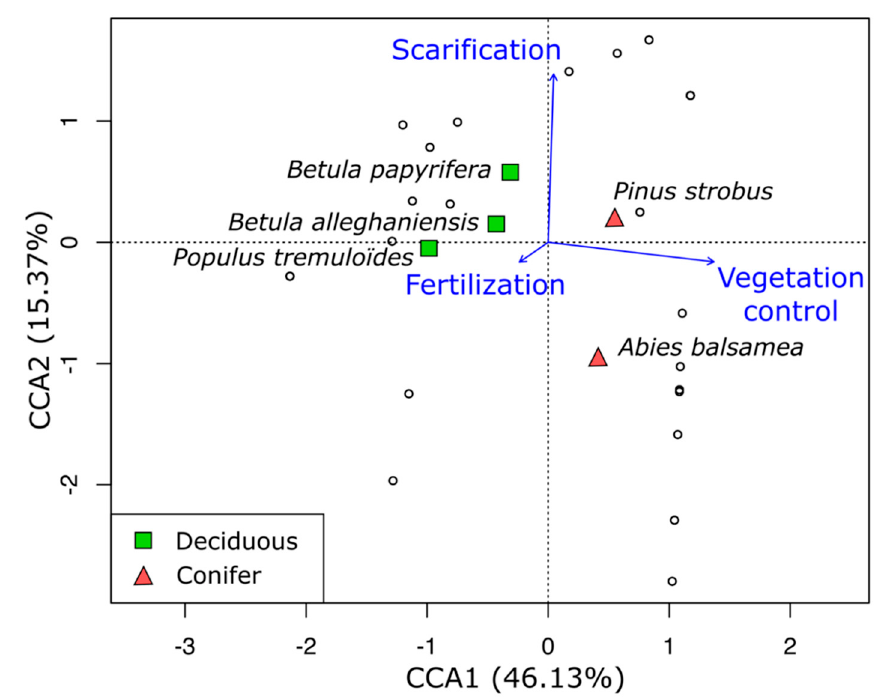
Figure 1. Canonical correspondence analysis of overstory vegetation composition using silvicultural treatments 27 years after establishment of a white pine plantation. Silvicultural treatments significantly explained overstory vegetation composition variation at p < 0.001 (R 2 adj = 0.49).